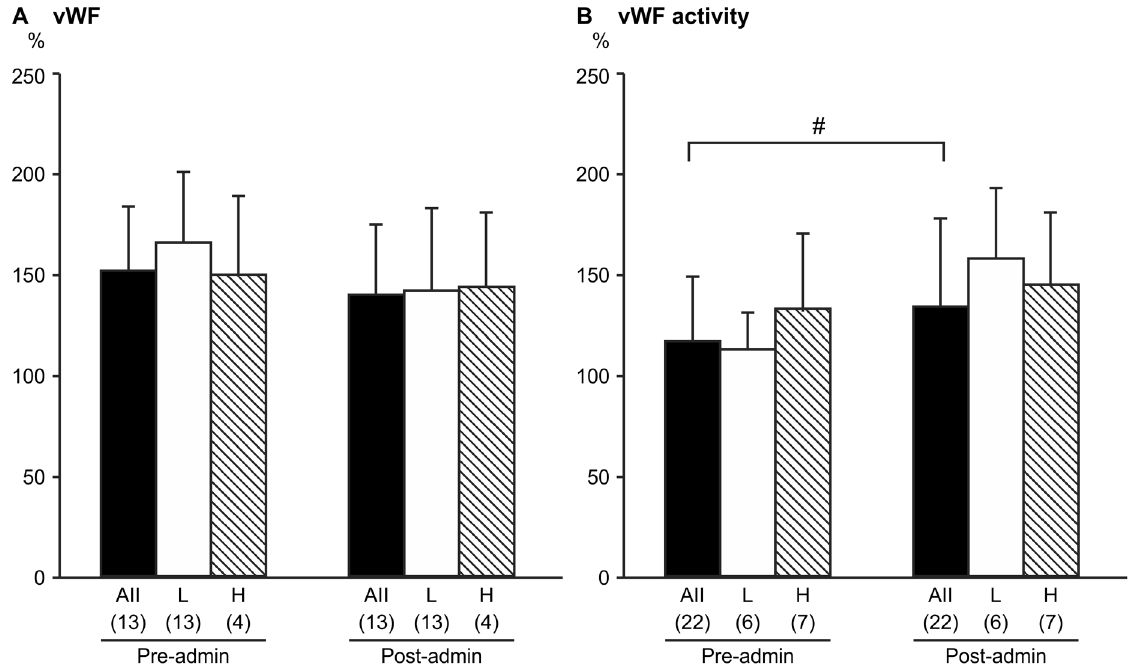
Figure 3. Levels and activity of von Willebrand factor (vWF) before and after pitavastatin treatment. Mean 6 standard deviation is shown for a) vWF levels and b) vWF activity. H indicates the group with homocysteine values above the median (8.6 m mol/L), L indicates the group with homocysteine values , 8.6 m mol/L. The number of subjects is indicated in parentheses. Pre- and post-pitavastatin values were compared using the Wilcoxon signed-rank test. # p , 0.05